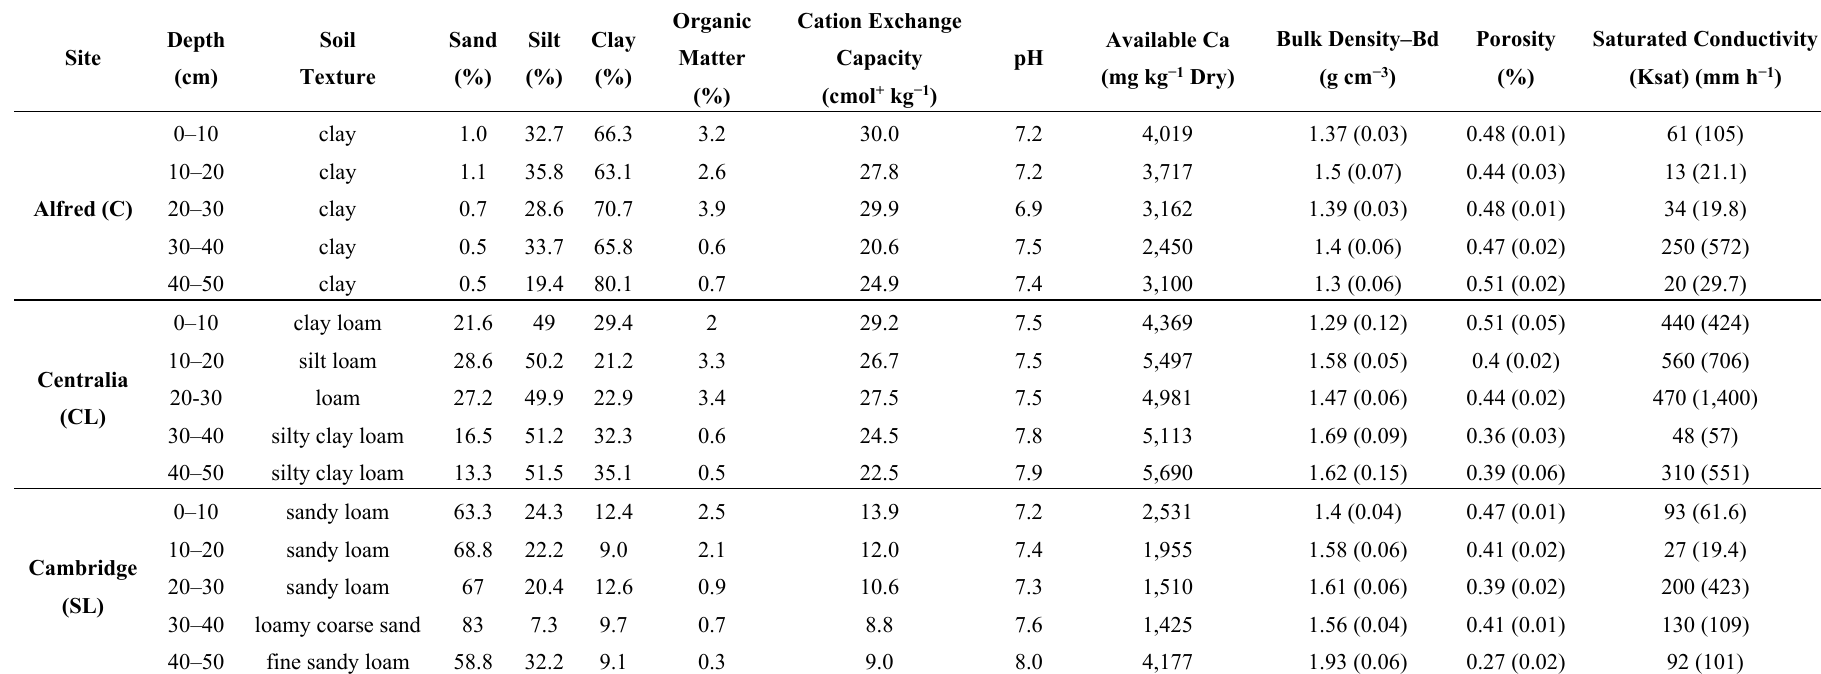
Table 1. Soil characteristics (mean and standard